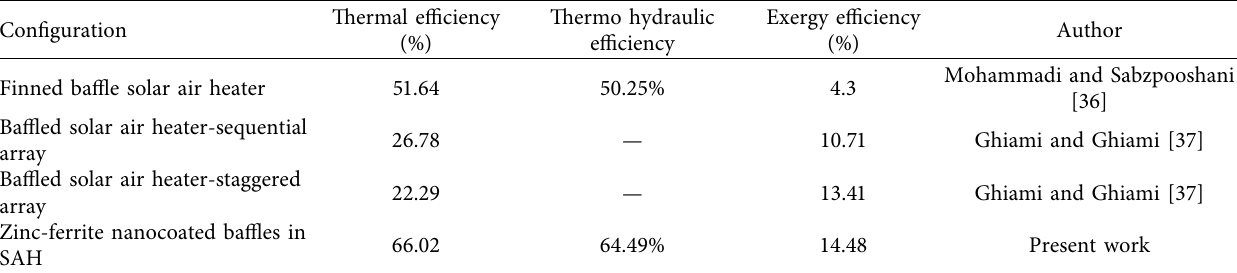
Table 2: Performance comparison with other confgurations of